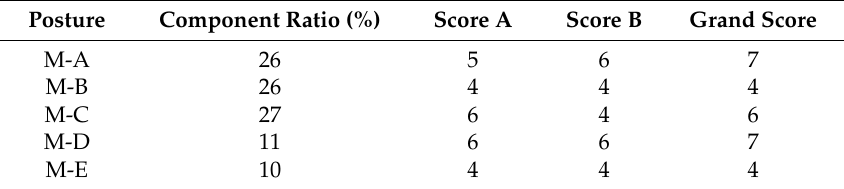
Table 5. RULA analysis results.